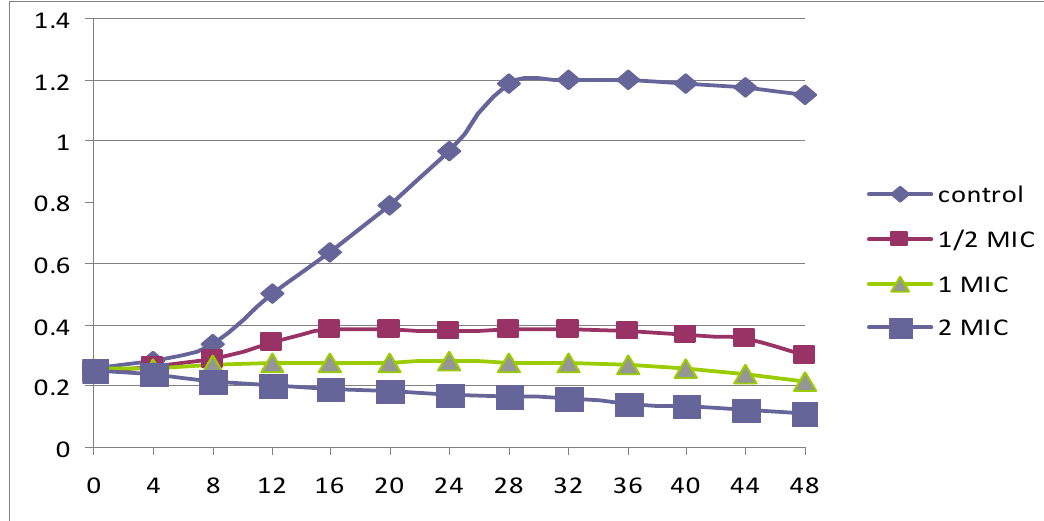
Figure 1. Growth curves of Candida albicans in Muller Hinton broth with 0 (control), ½, 1 and 2 times MIC (3.125) of Euphorbia hirta leaves extract after 48 h